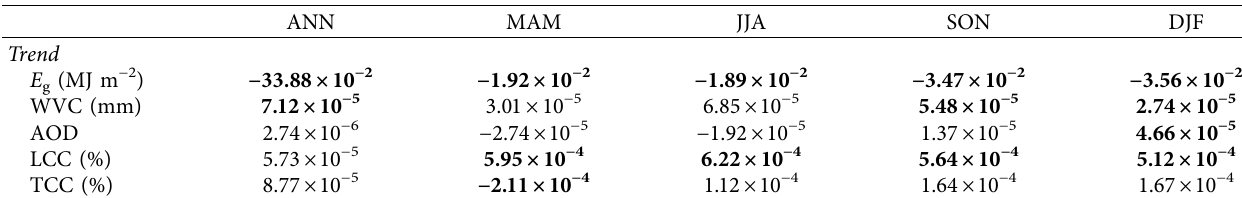
Table 1: Annual and seasonal trends in E g , WVC, AOD, TCC, and LCC per decade and their correlation coefficients. ANN